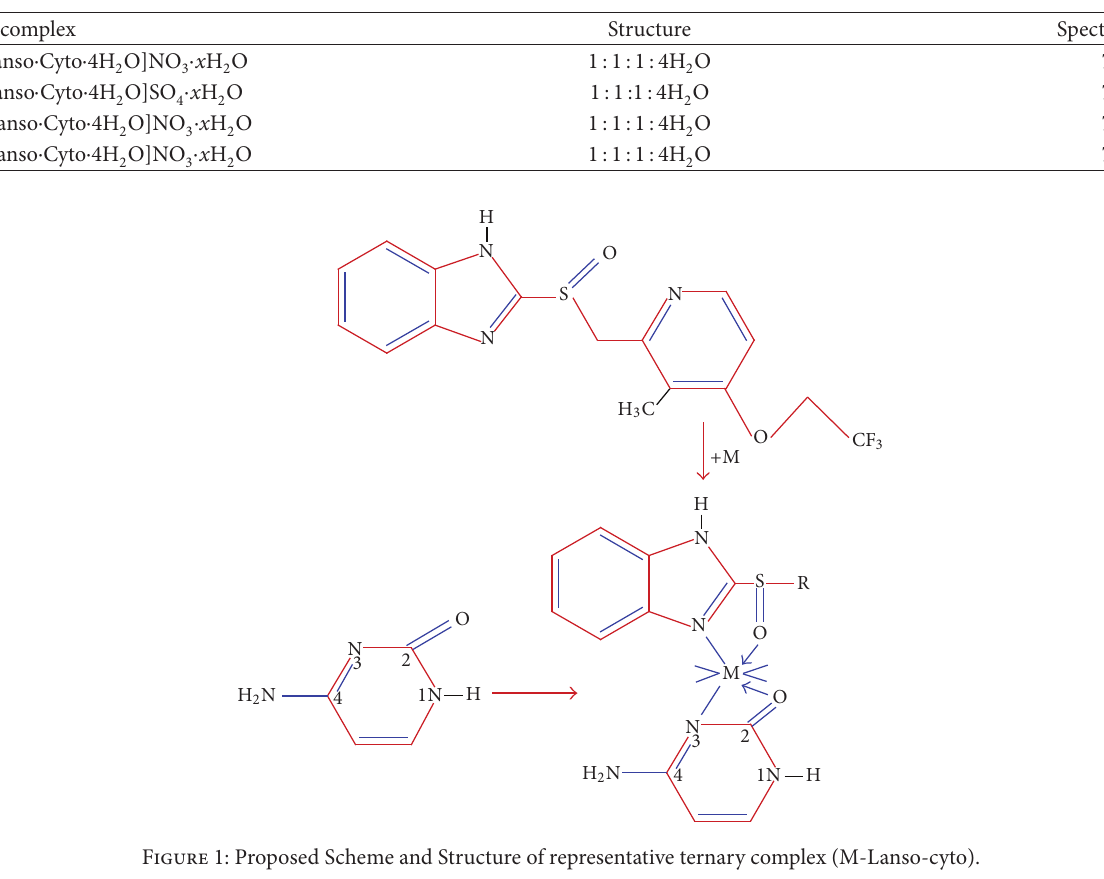
T 6: Mass spectra of mixed ligand complexes of Lanso and Cyto.